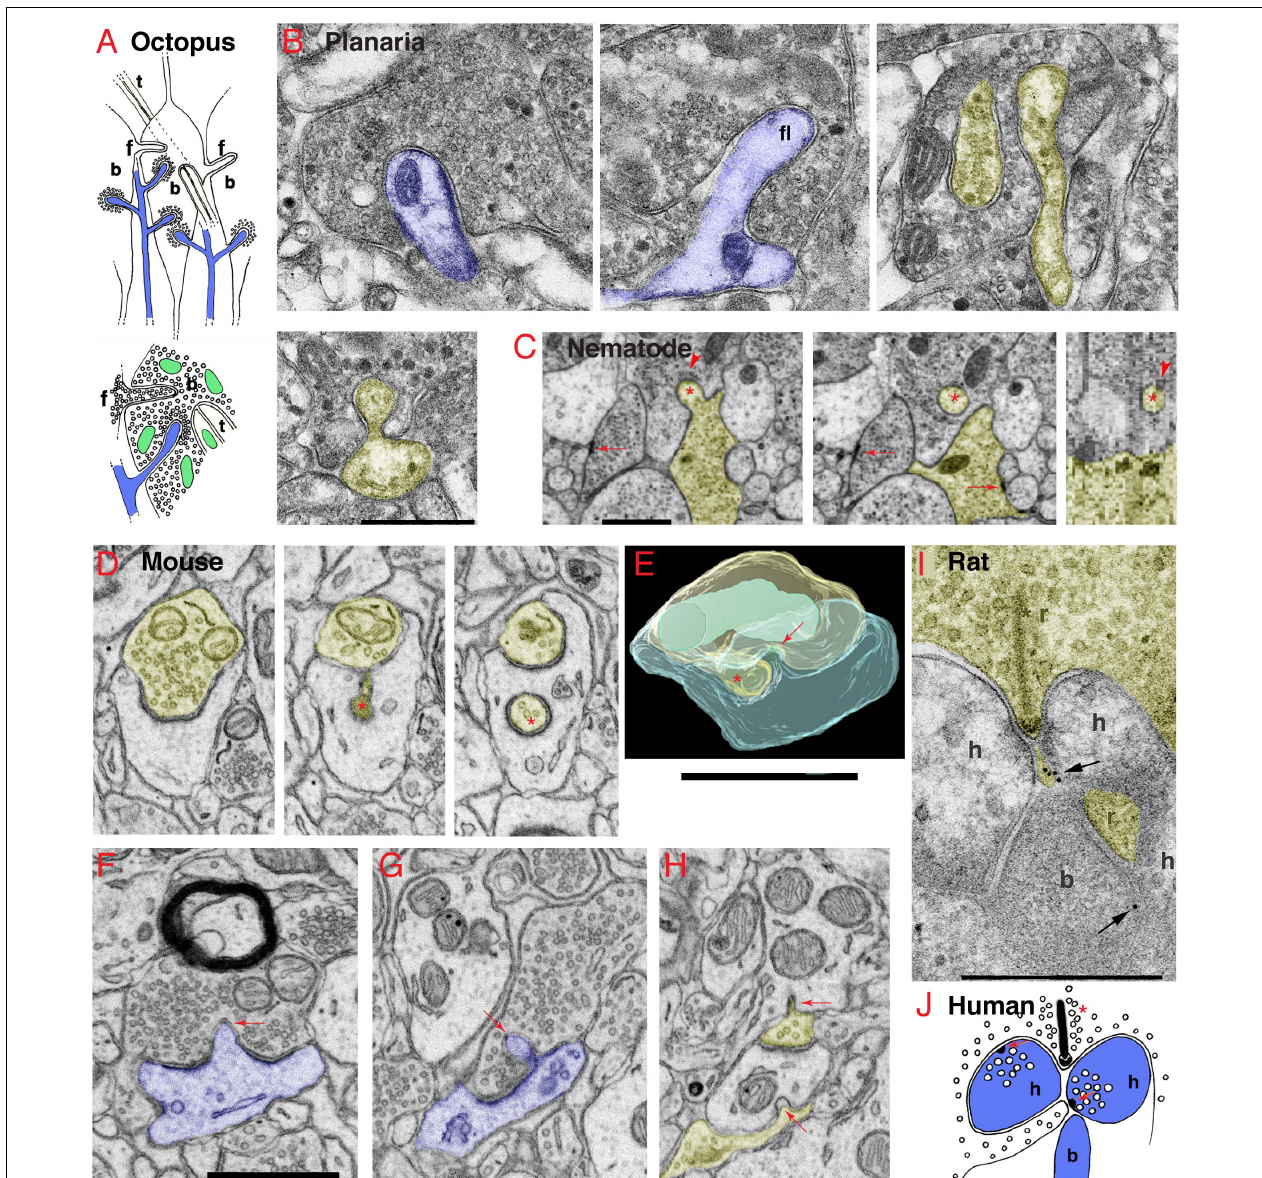
FIGURE 1 | Invaginating structures are common in animal synapses. (A) Drawings recapitulating the octopus’s large en passant photoreceptor terminals, called “bags” ( b ) or “carrots.” The bags are filled with synaptic vesicles (shown in lower drawing) and contain three types of invaginating structures from three different sources, including: (1) postsynaptic spines ( blue ) with a dense layer of synaptic vesicles surrounding the deeply invaginating spine heads; (2) presynaptic terminals, also called “finger twigs” ( f ), which are filled with synaptic vesicles (lower drawing), invaginating from adjacent bags; and (3) “tunnel fibers” ( t ), which are one or more nerve trunks passing in a “tunnel” through the bag at ∼ right angles to the invaginating spines and originating from small neurons called “microneurons.” Mitochondria are green . Drawings are from Petralia et al. (2017) with slight modifications. (B) Electron microscopy (EM) images of the planaria brain synapses. The invaginating structures include an invaginating postsynaptic dendrite ( blue , left image), an invaginating filopodium ( f , middle image), and interdigitating axon terminals ( yellow and uncolored , right image). In the EM image on the left in the 2nd row, an unidentified projection invaginates into an axonal terminal ( yellow ) with large dense-cored vesicles. (C) EM images show an invaginating structure from the ventral ganglion of the nematode, Pristionchus pacificus (Bumbarger et al., 2013; serial cross-section online data set in Neurodata OCP). An invaginating structure ( asterisk ) originates from an axon terminal ( yellow ), which is one of two vesicle-filled terminals that form typical nematode dyadic synapses with a presynaptic density ( arrows ) centered between two postsynaptic processes (lacking PSD; White et al., 1986; Hall and Russell, 1991). The invaginating process enters into the base of a neurite extending from a neuron soma of the ventral ganglion (cell matches descriptions of neurons by position and structure; Ware et al., 1975; White et al., 1986). A possible junction may occur on the dorsal aspect of the invaginating process where the membranes appear denser and there are unidentified subsynaptic structures ( arrowheads ) in the postsynaptic cell. The left two images are transverse sections (z positions 2017 and 2019 in the image stack), and the right image is a digitally reconstructed parasagittal section. (D–H) Invaginating structures in the mouse nucleus accumbens. (D) An invaginating presynaptic terminal ( yellow ). The z positions in the FIB-SEM image stack are 144, 202, and 237 for the